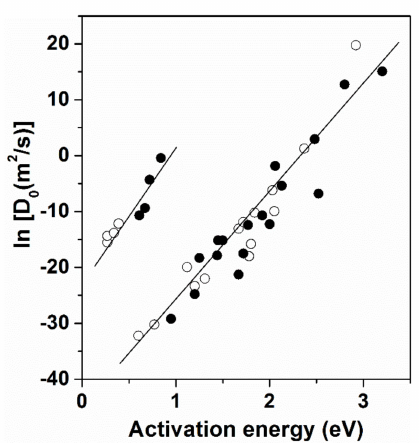
Figure 37. lnD o for H and several substitutional atoms versus the activation energy. Adopted from [131], with permission from Cambridge University Press, 2011.